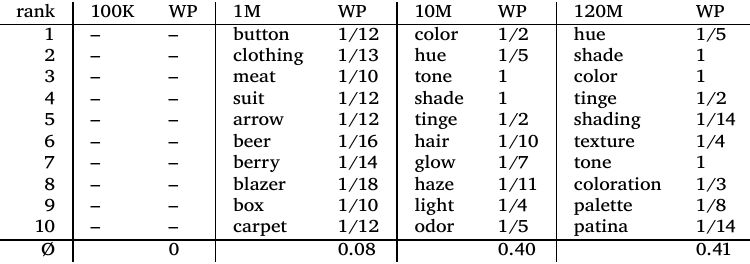
Figure 6: DT entries for “tint” with WordNet path similarities (WP), comparing different corpus sizes from 100K sentences up to 120M